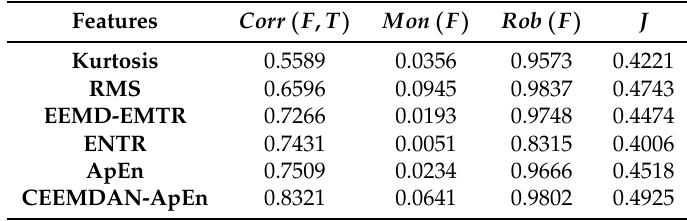
Table 2. The performance of all kinds of features. RMS = root mean square.